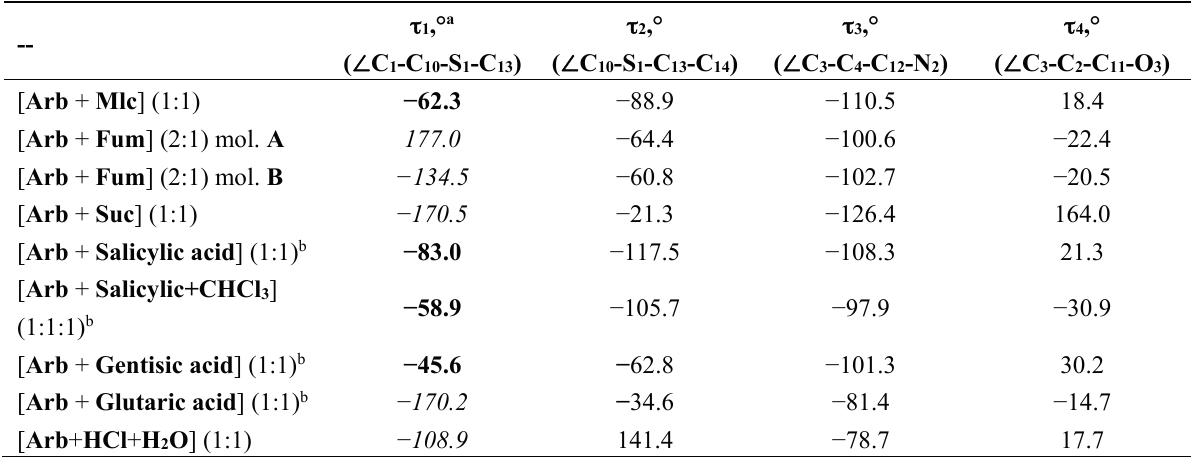
Table 2. Selected torsion angles  1 ,  2 ,  3 , and  4 for arbidol ion (zwitterion) in the known crystal